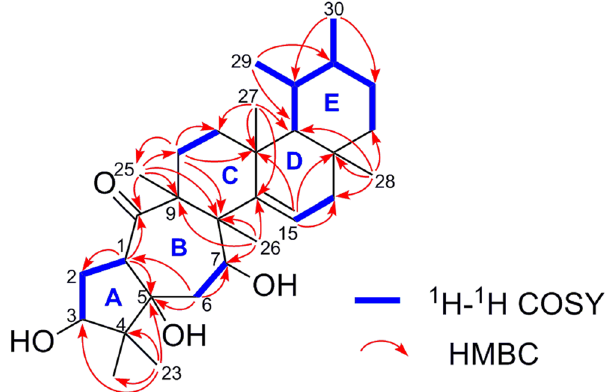
Figure 2. 1 H ‒ 1 H COSY and key HMBC correlations of ( 1